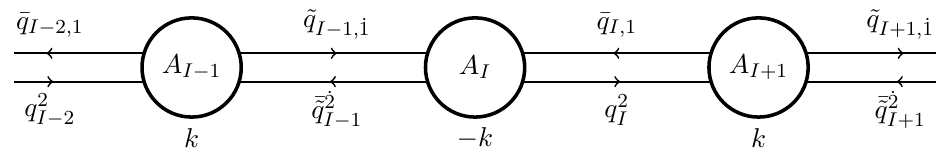
Figure 2 . The decomposition of the N = 4 matter multiplets into pairs of chiral multiplets. Only the chiral scalar of each multiplet is indicated